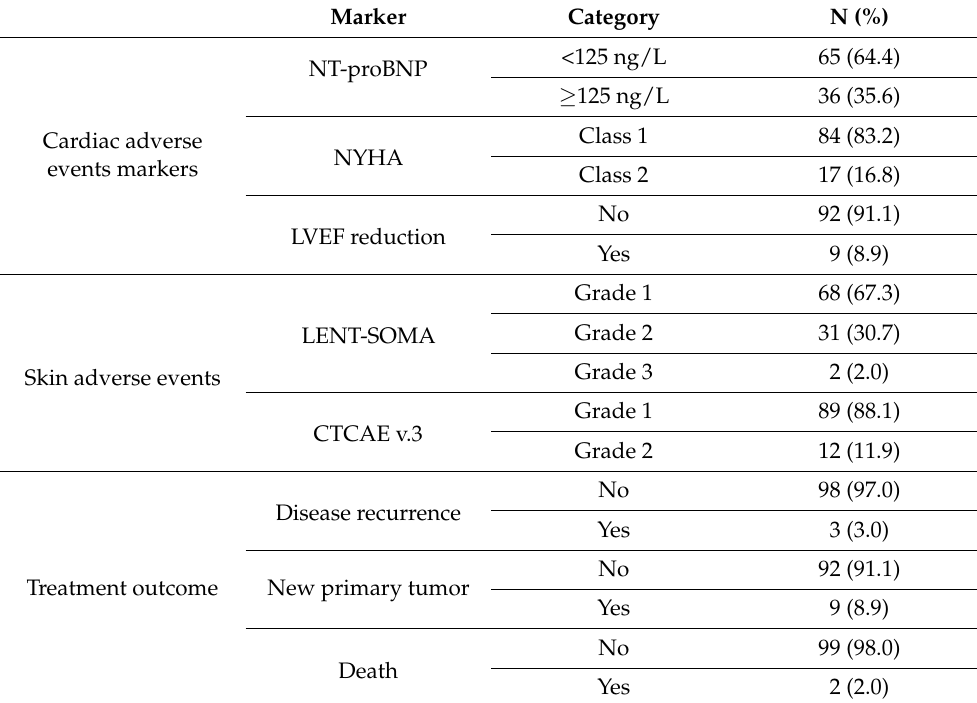
Table 3. Markers of late cardiac and skin adverse events of breast cancer therapy and treatment outcome. Marker Category N (%) <125 ng/L 65 (64.4) NT-proBNP ≥ 125 ng/L 36 (35.6) Class 1 Cardiac adverse NYHA events markers